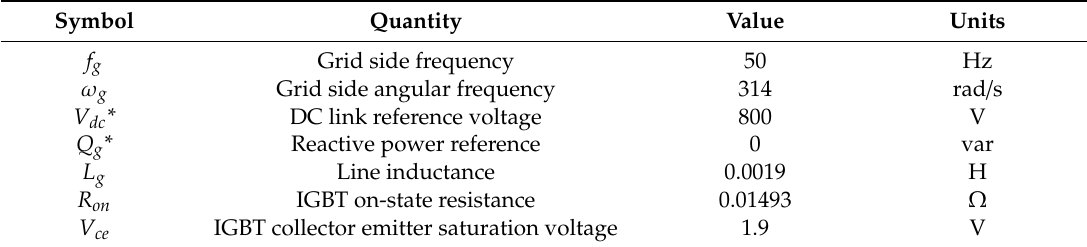
Table 3. Parameters for the BTB power converters and VOC.